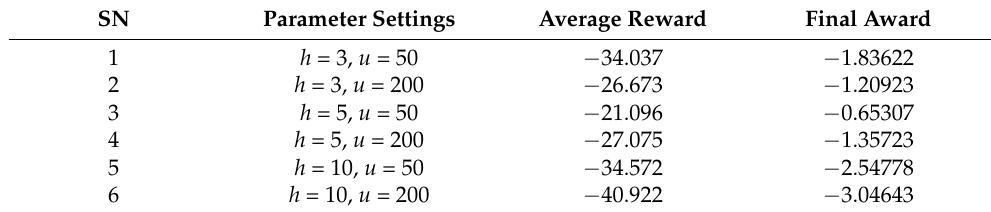
Table 2. Convergence test results under different parameters.